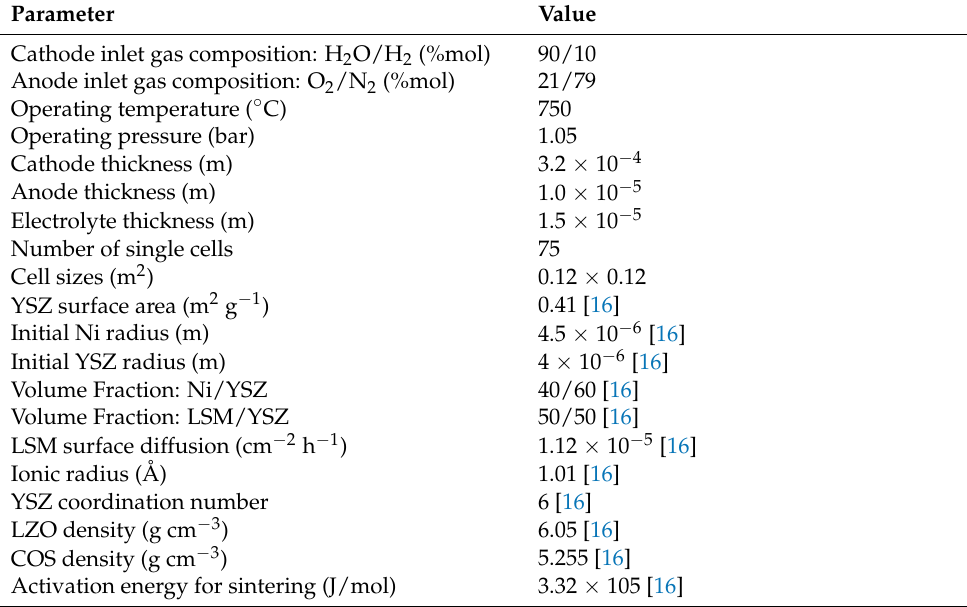
Table 1. Some parameters used in SOEC